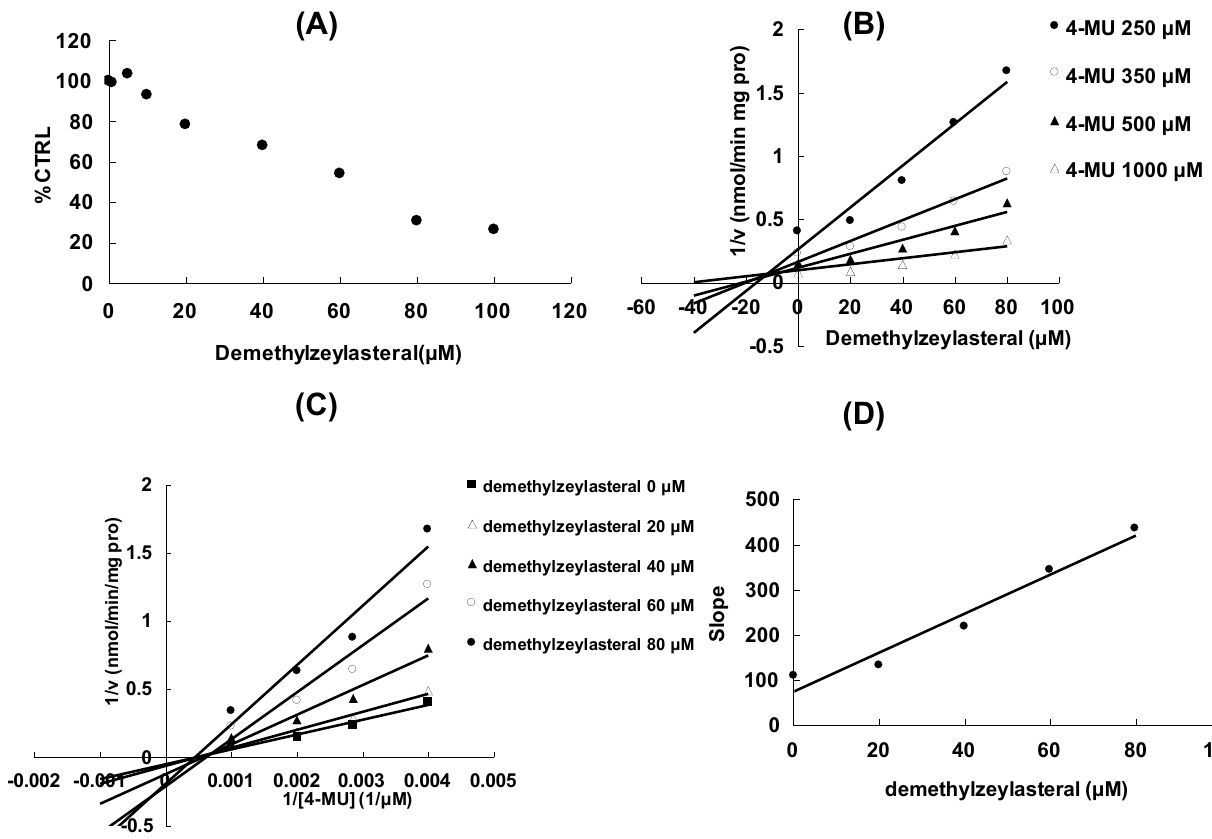
Figure 3. Inhibition kinetic analysis of demethylzeylasteral towards recombinant UGT2B7-catalyzed 4-MU glucuronidation. ( A ) Demethylzeylasteral showed dose-dependent inhibition towards UGT2B7; ( B ) Dixon plot of demethylzeylasteral inhibition towards UGT2B7-catalyzed 4-MU glucuronidation; ( C ) Lineweaver-Burk plot of demethylzeylasteral inhibition towards UGT2B7-catalyzed 4-MU glucuronidation; ( D ) Second plot using slope (obtained from Lineweaver-Burk plot) vs. the concentration of